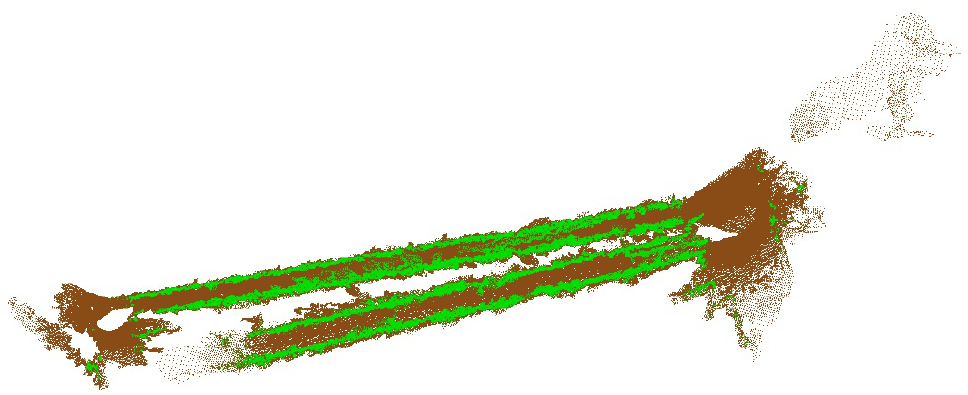
( b ) Top-view coloured image of the canopy occupancy area. The green colour represents the canopy and the brown colour is the soil. Figure 12. The top-view images representing the volume ( a ) and the occupancy area ( b ) of the vineyard segment. Both images were obtained using a variance threshold of 0.15 m².